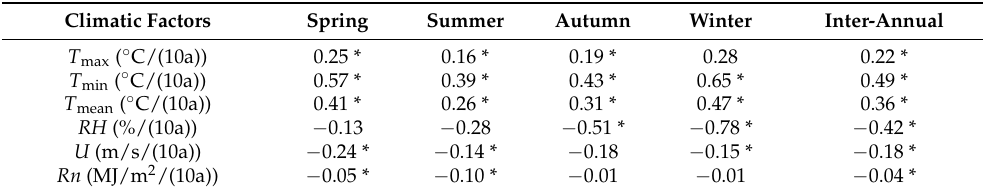
Seasonal and inter-annual climate tendency rate of meteorological factors in Hei- longjiang Province. Climatic